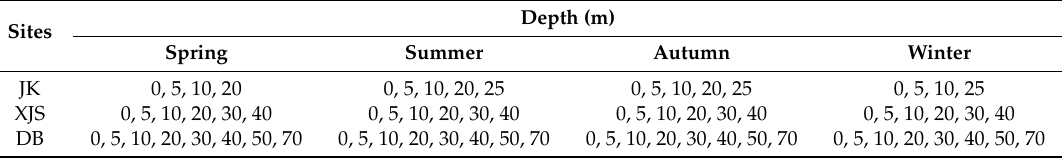
Table 1. The multiple depths of JK, XJS, and DB sampled in each season of Lake Qiandaohu. Depth (m) Sites Spring Summer Autumn Winter JK 0, 5, 10,